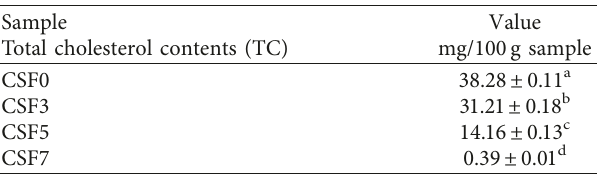
Table 9: Total cholesterol contents of cakes with chia seed flour (CSF).